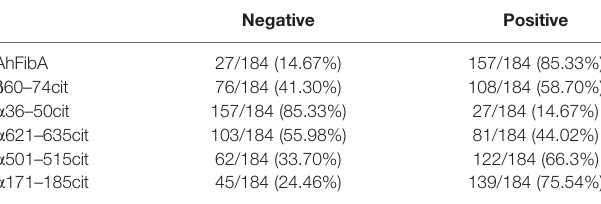
TABLE 2 | AhFibA and fi ve major citrullinated Fibrin peptides